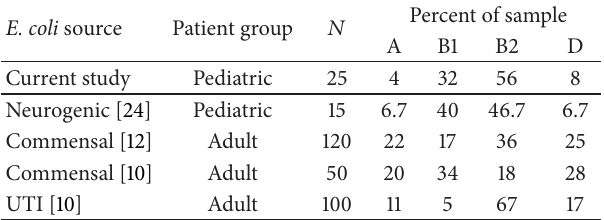
Table 1: Phylotypes of E. coli